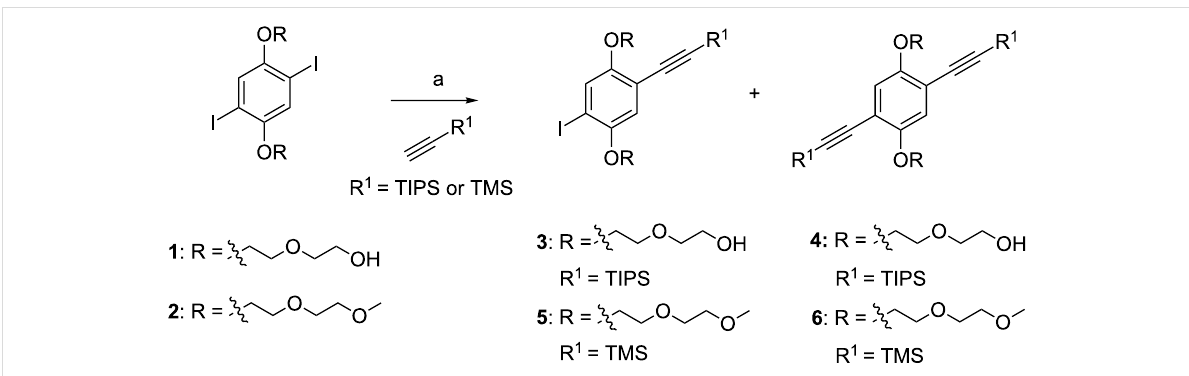
Scheme 1: Synthesis of building blocks; (a) from 1 , Pd(PPh 3 ) 4 , CuI, PPh 3 , TEA, toluene, 50 °C, 5 h, 31% for 3 and 50% for 4 ; from 2 , PdCl 2 (PPh 3 ) 2 , CuI, TEA, THF, microwave, 60 °C, 20 min, 35% for 5 and 53% for 6